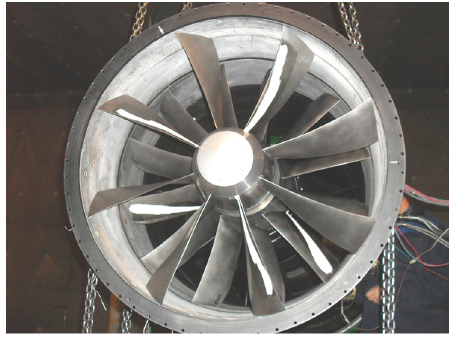
Figure 35. Rotor 1 of COBRA1 fan.